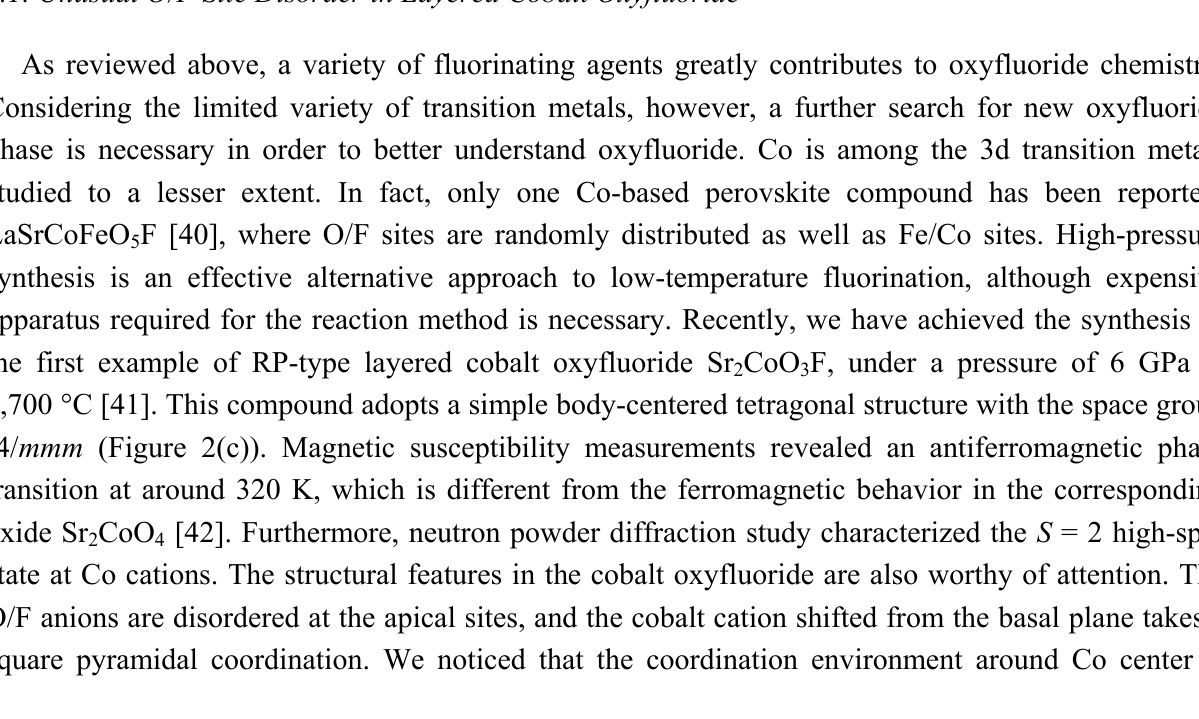
TiO F , ( b ) Ba 2 3 2